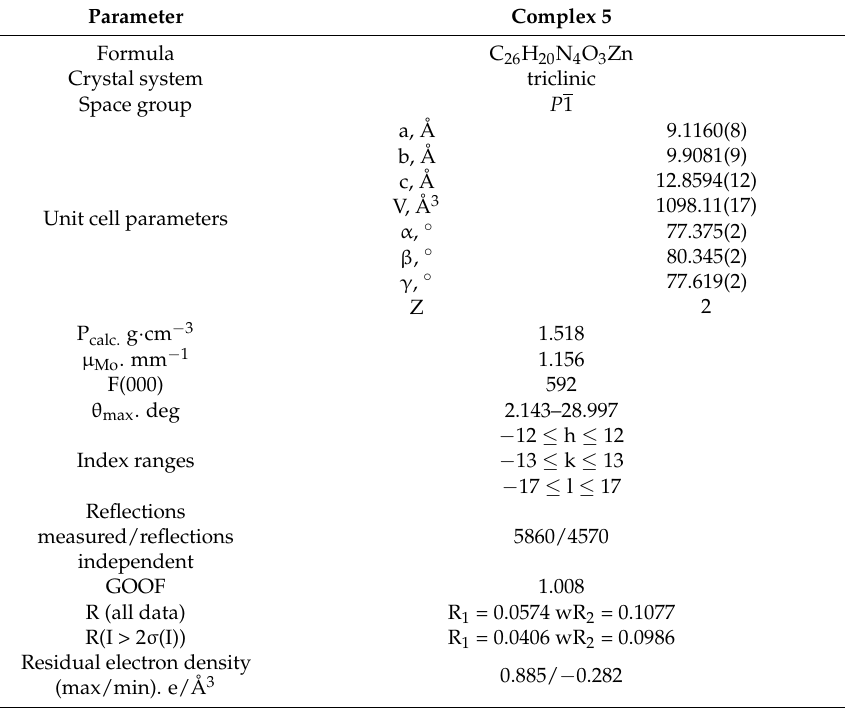
Table 1. Crystallographic and structural determination data for complex